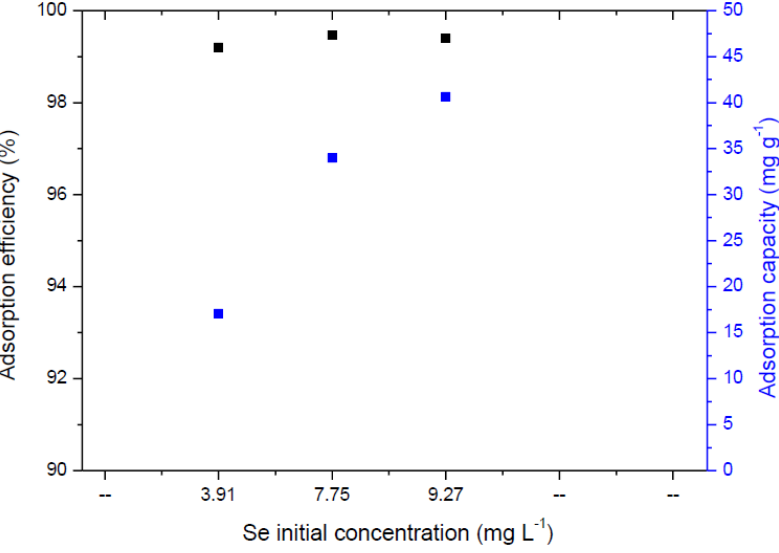
Figure 2. The effect of selenium initial concentration on adsorption efficiency/capacity.